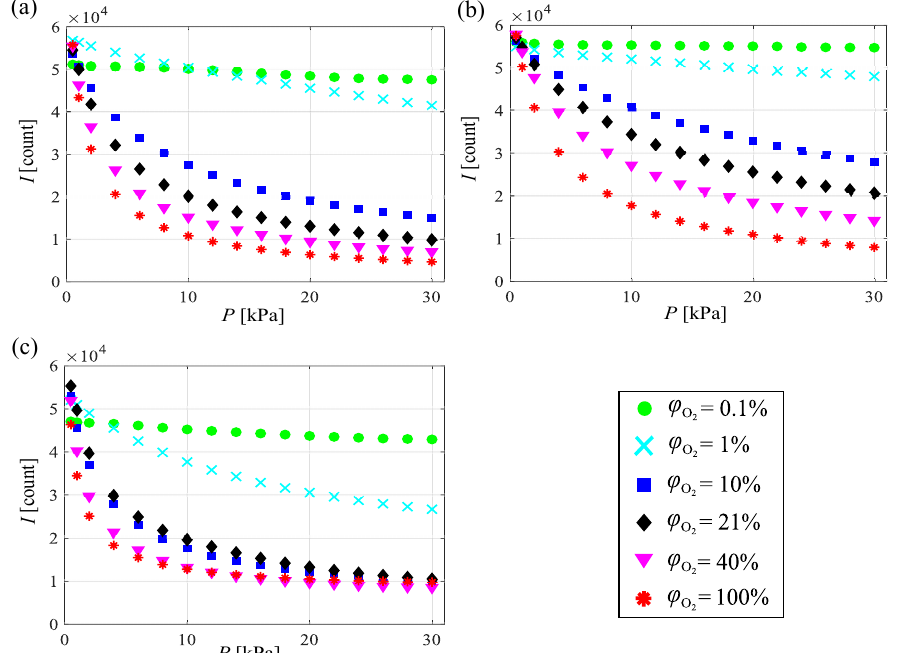
Figure 3. Intensity of PSP emission at various oxygen mole fractions for ( a ) PHFIPM-PSP, ( b ) PC-PSP, and ( c )